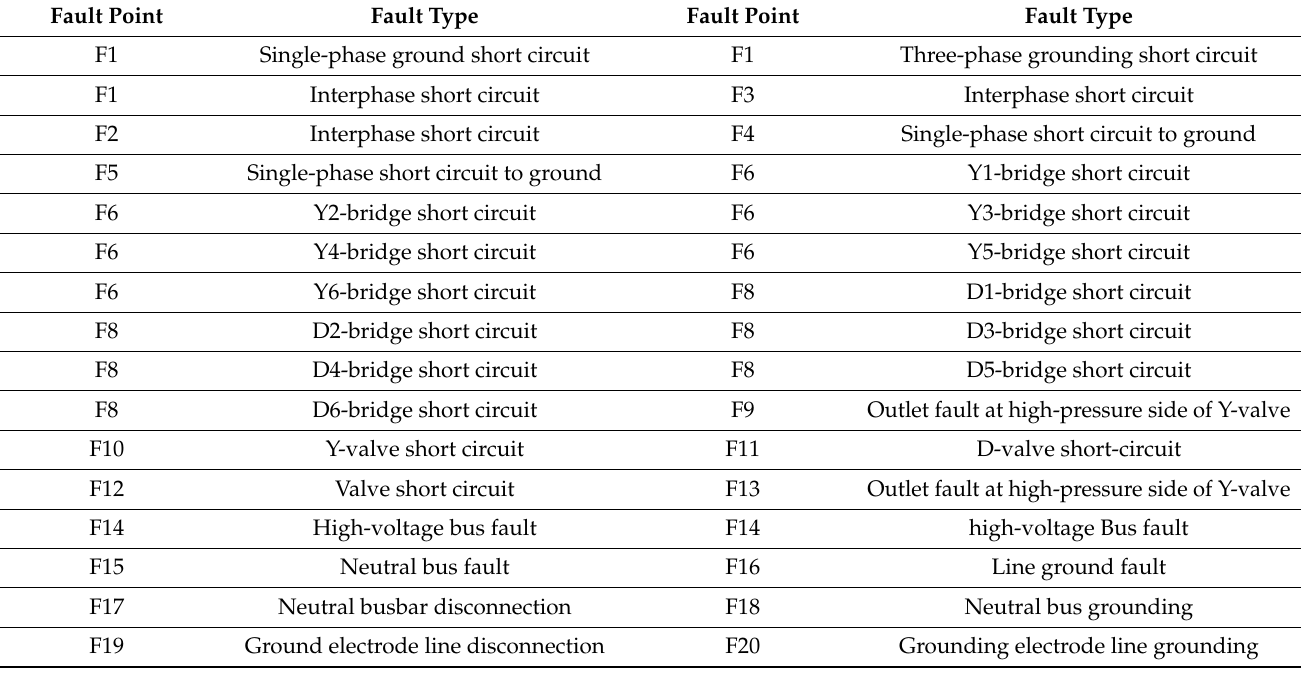
Table 1. Fault types of fault points of a substation in a southwest power grid in